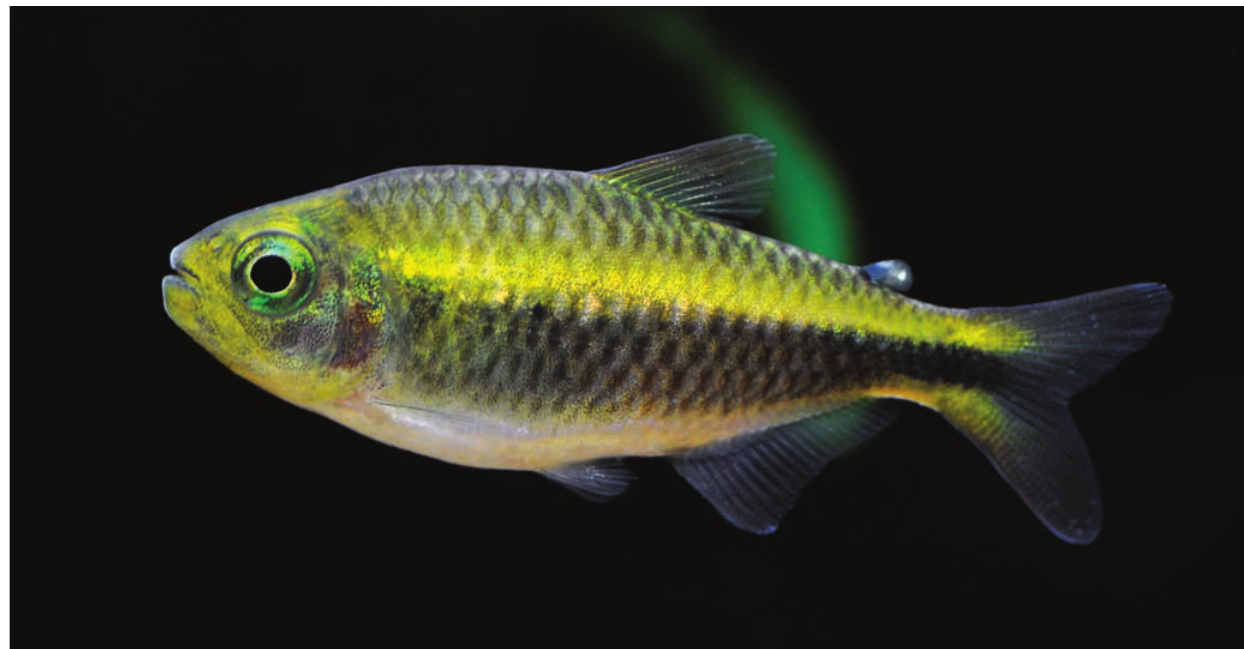
Fig. 2. Moenkhausia chlorophthalma , aquarium specimen showing live coloration, Brazil, Pará, Altamira, rio Treze de Maio, collected with holotype.